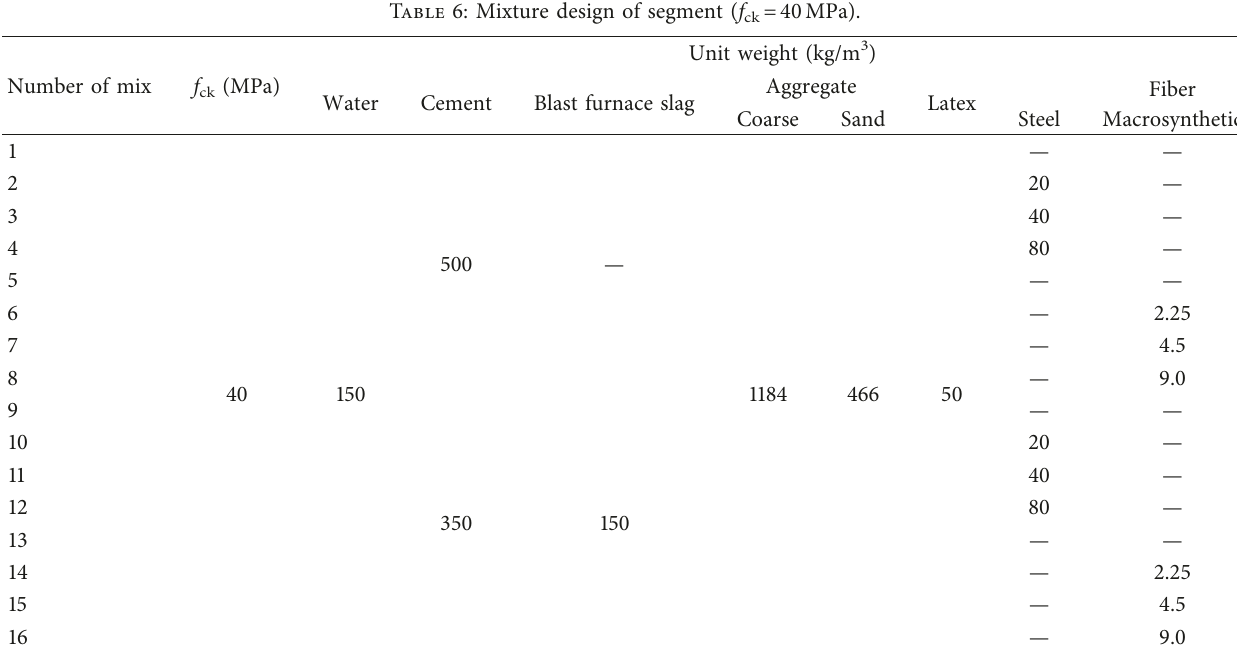
Table 6: Mixture design of segment ( f